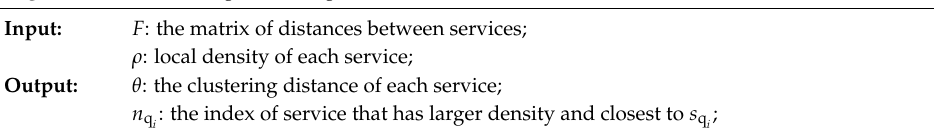
Algorithm 1. Calculating Clustering Distance